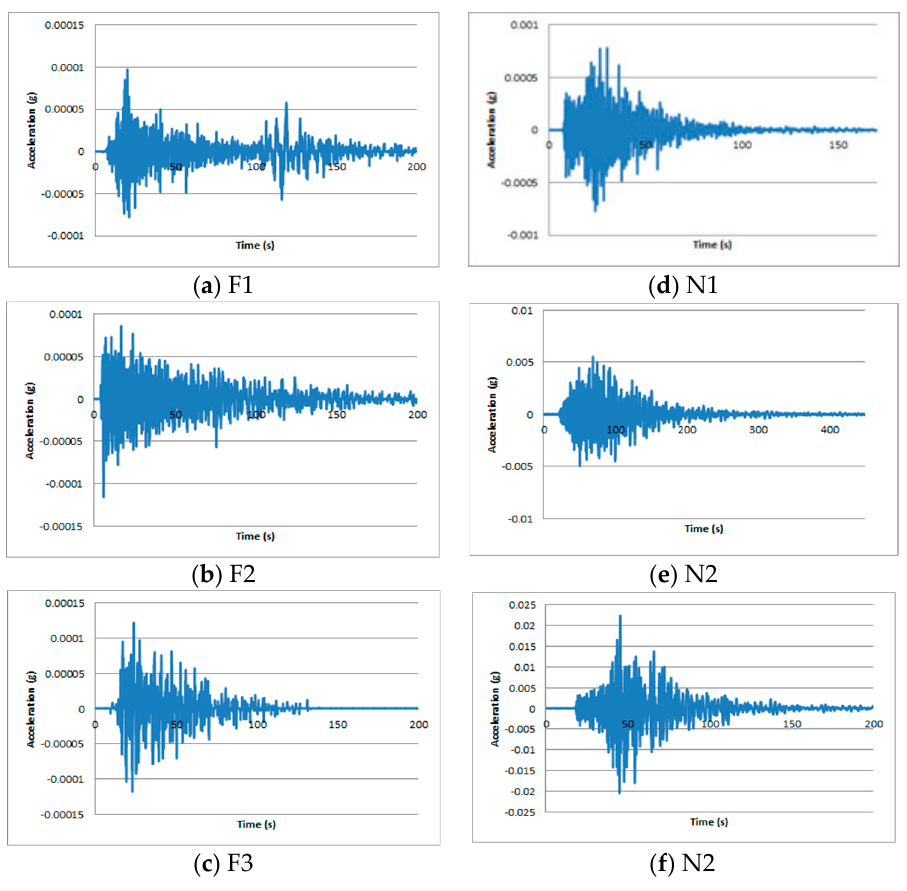
Figure 5. Seismic time histories. Table 1. Correlation of CPT-Vs used in the present